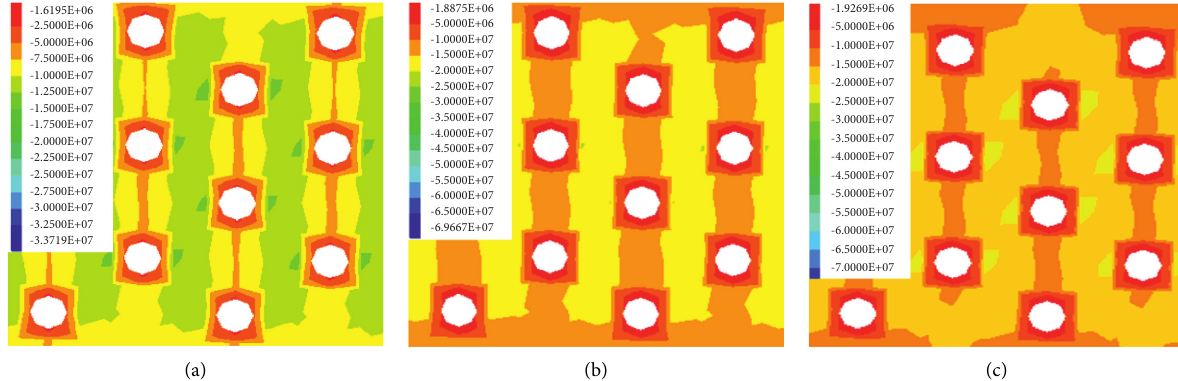
Figure 8: Vertical stress distribution of 300 mm pressure relief hole in different depths along the axis direction. (a) 2 m from the coal rib. (b) 4 m from the coal rib. (c) 6 m from the coal rib.